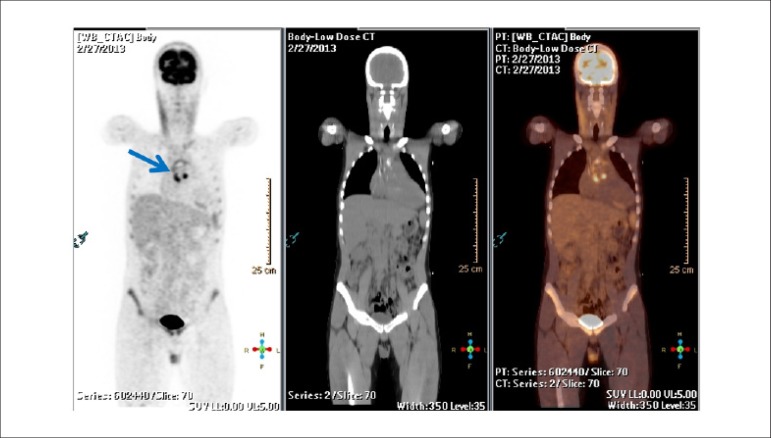
Male patient, age 19, with biological prosthesis in the aorta and mitral annuloplasty for 45 days. He evolved with fever, bacteremia, and blood culture positive for S. Epidermidis. FDG-18F - PET/CT study was positive for infection in the aortic prosthesis; maximum standard uptake value (SUV) = 9.7.